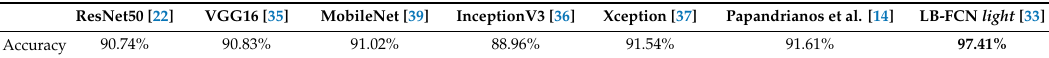
Table 5. Overall classification accuracy comparative results.